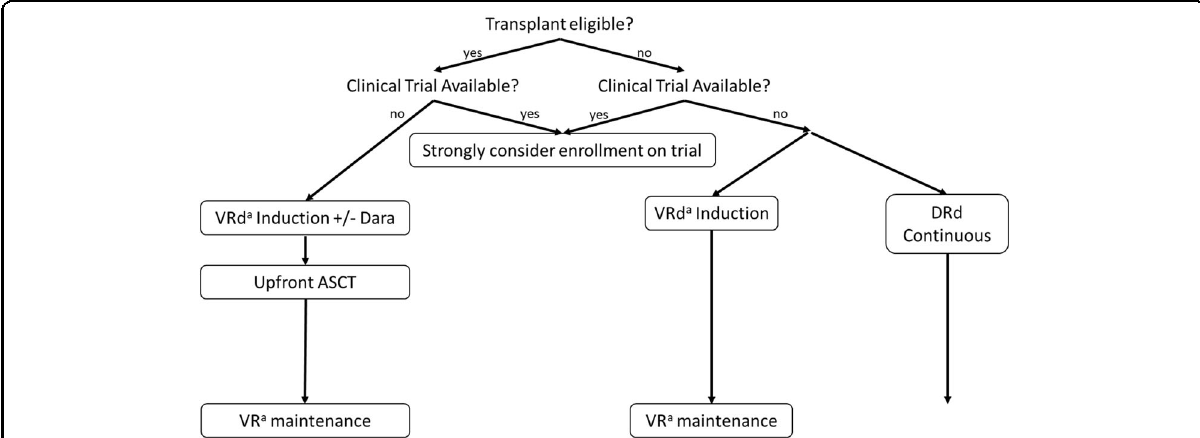
Fig. 1 Proposed management recommendations for patients with newly diagnosed multiple myeloma and + 1q21 by FISH. V = bortezomib; R or Len = lenalidomide; d = dexamethasone; Dara or D = daratumumab; ASCT = autologous stem cell transplantation with high-dose melphalan conditioning; HR CA = high risk cytogenetic abnormalities. a Car fi lzomib may be substituted for bortezomib if neuropathy is